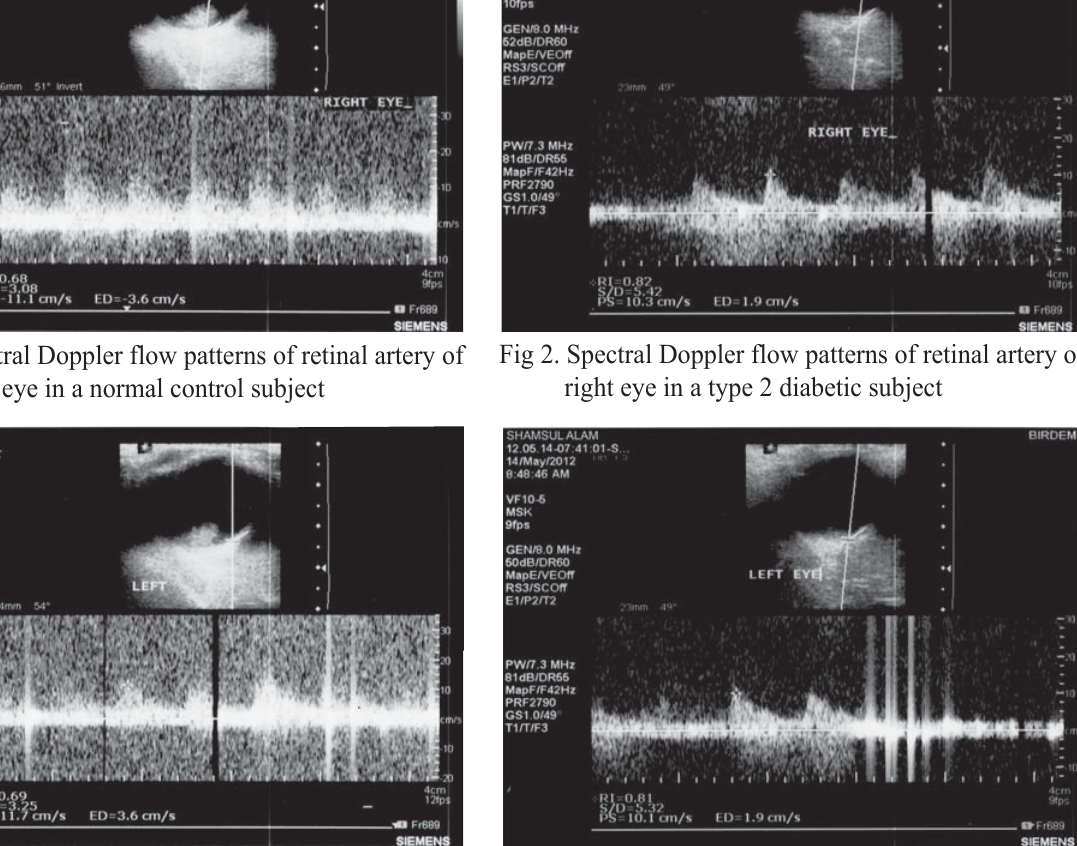
Fig 3. Spectral Doppler flow patterns of retinal artery of left eye in a normal control subject